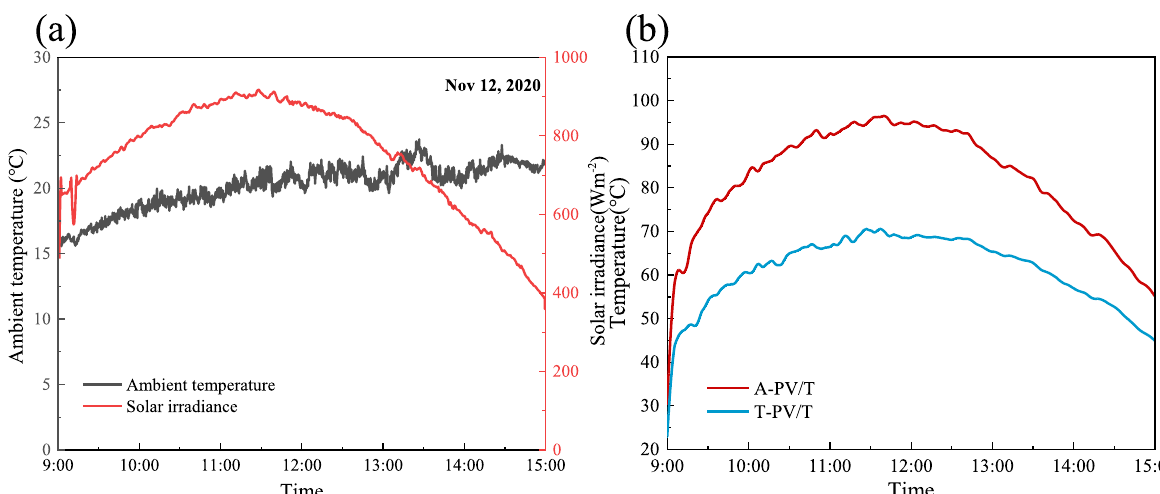
Fig. 12 a Measured ambient temperature and solar irradiance. b Measured cell temperature in two PV/T